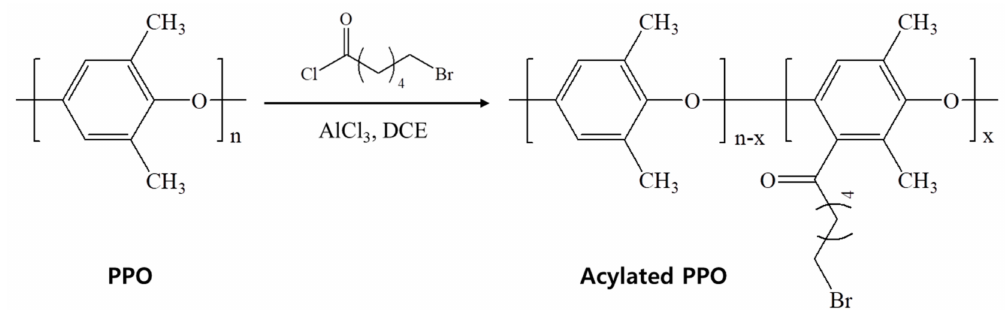
Figure 1. Scheme of the acylated poly(phenylene oxide)